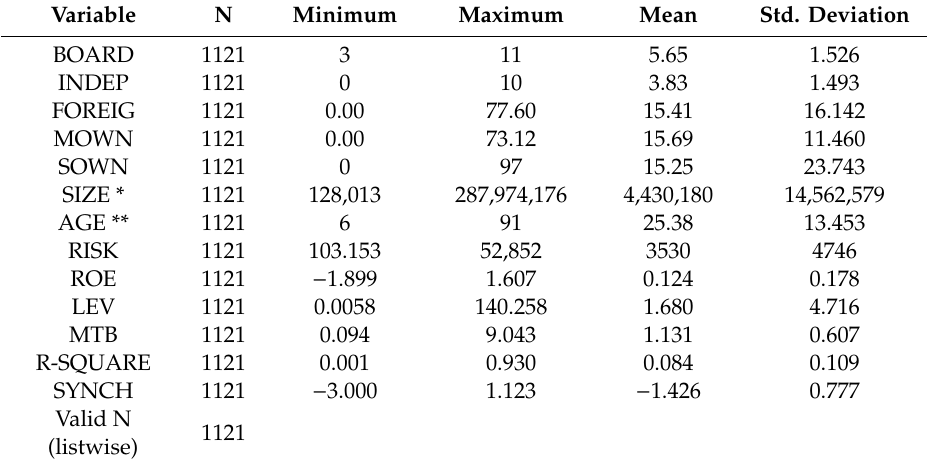
Table 2. Descriptive